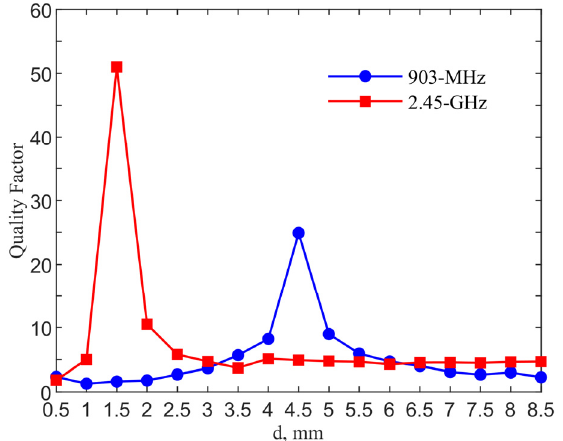
Figure 6. Quality factors of the loop with tuning pad at the two ISM bands for the implant depth of 6 mm.